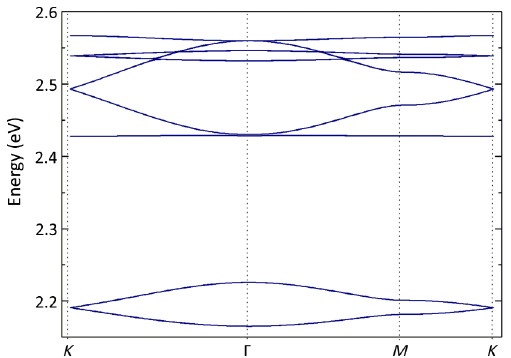
FIG. 11 (color online). Lowest conduction bands of a graphene- type honeycomb lattice of spherical nanocrystals of CdSe (diameter ¼ 4 . 7 nm). Nearest-neighbor nanocrystals are con- nected by cylindrical bridges of CdSe (diameter of the cylinders ¼ 2 .